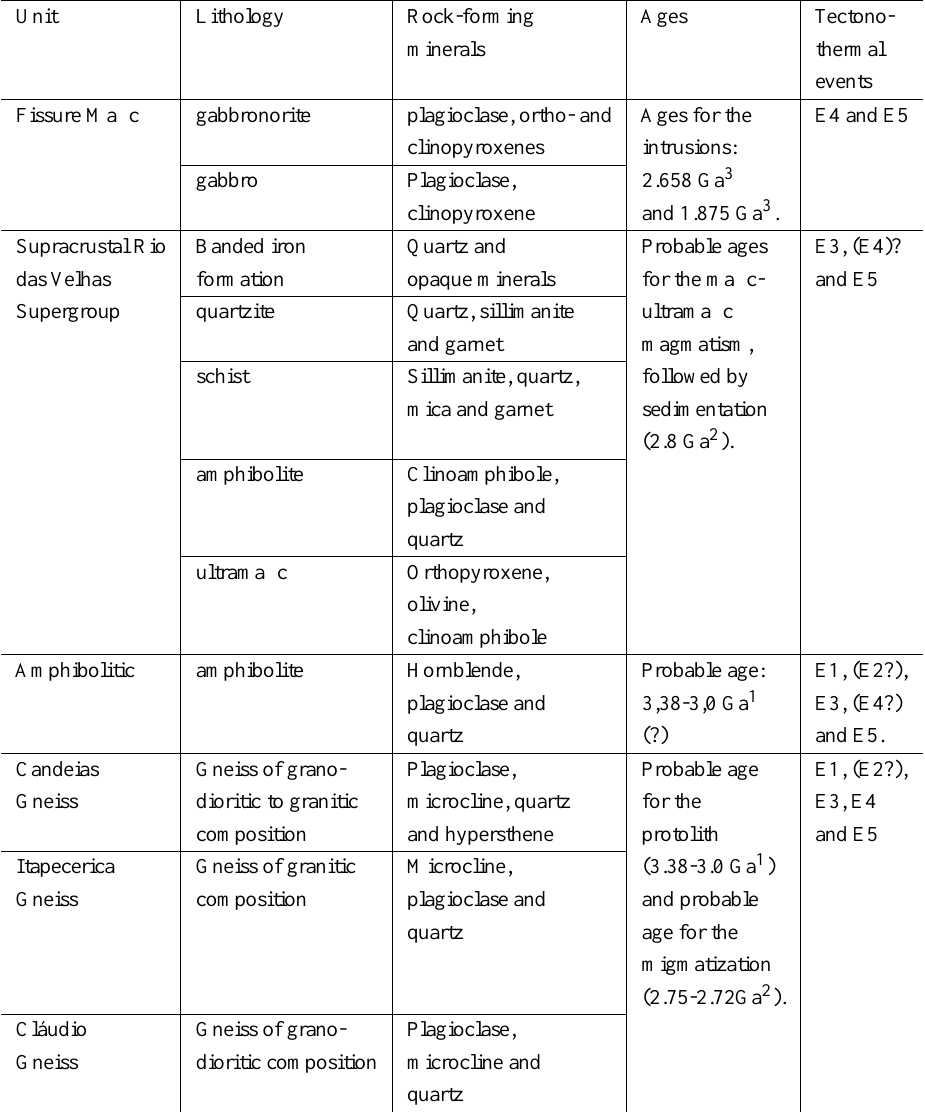
General characteristics of the rocks types of the study area and their probable ages and tectonothermal